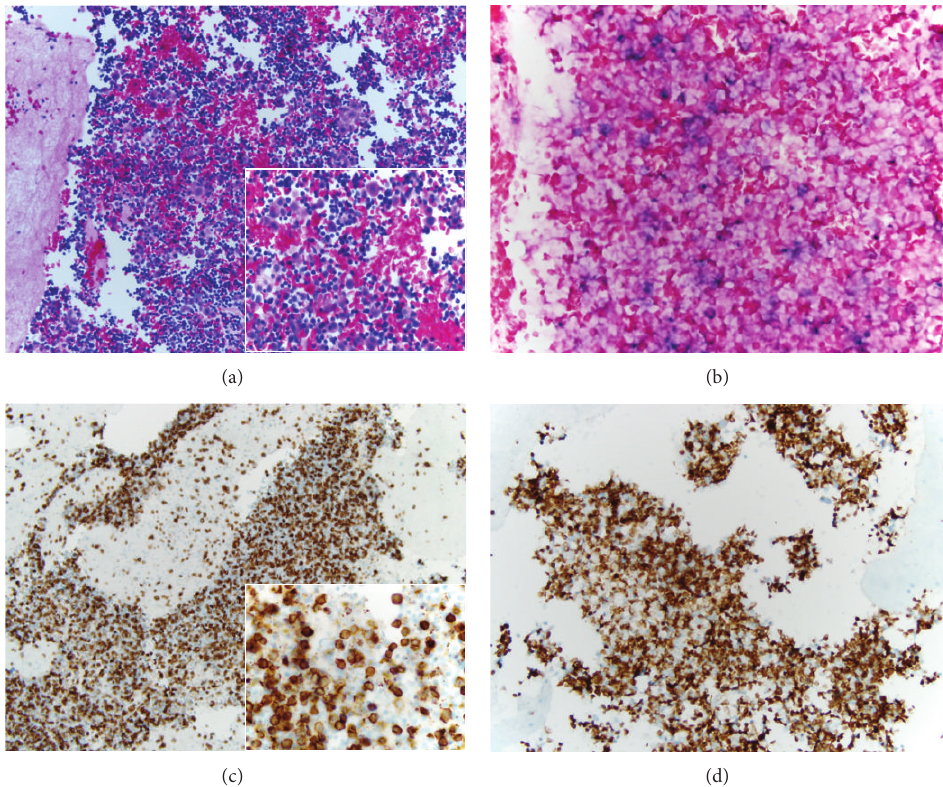
Figure 2: (a) Pleural fluid cell block showing mixed population with background atypical cells H&E 200x. Inset highlighting the hidden atypicalcellsH&E400x.(b)EBERwithpositiveatypicalcells.(c)and(d)CD20andCD3stains100x,respectively,showingamixedpopulation with the atypical cells positive for CD20 (inset